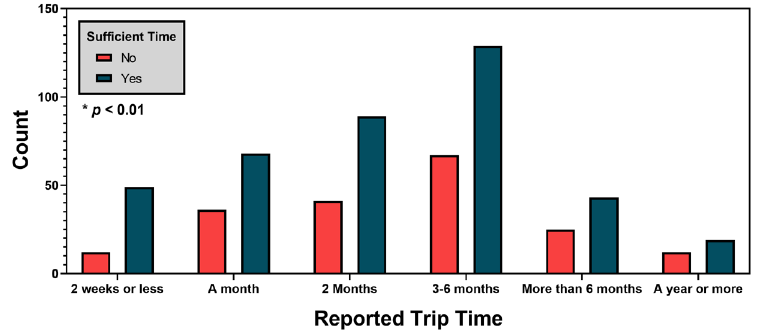
Figure 4. Sufficiency of Time Based on Trip Length.